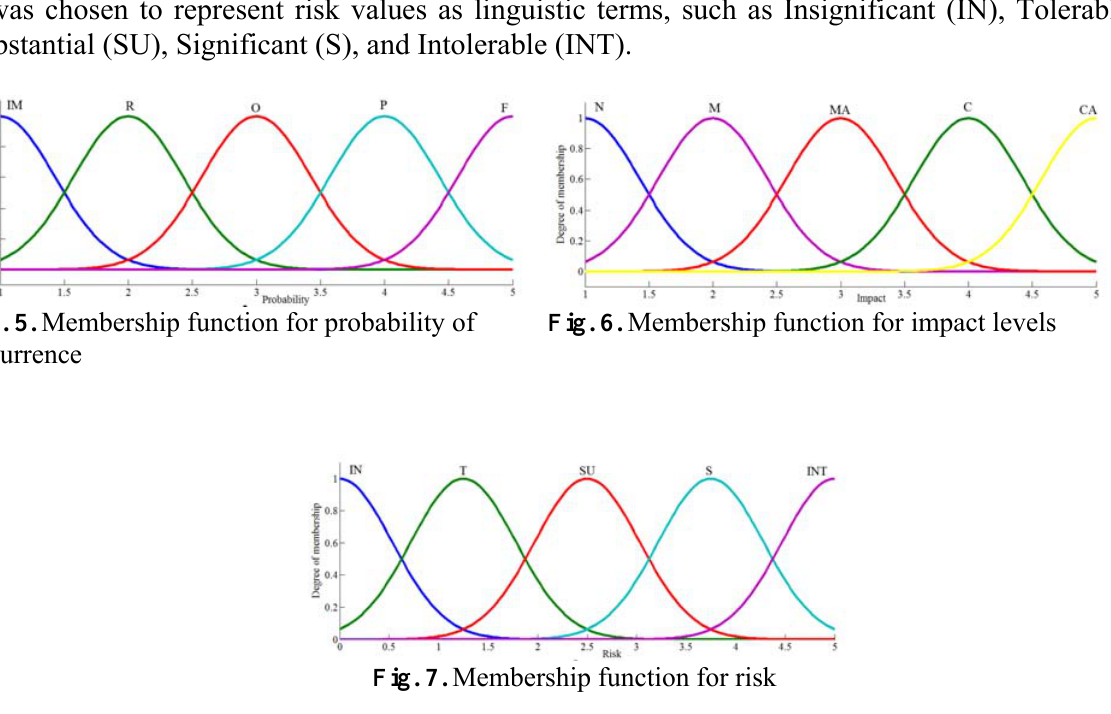
Fig. 7. Membership function for